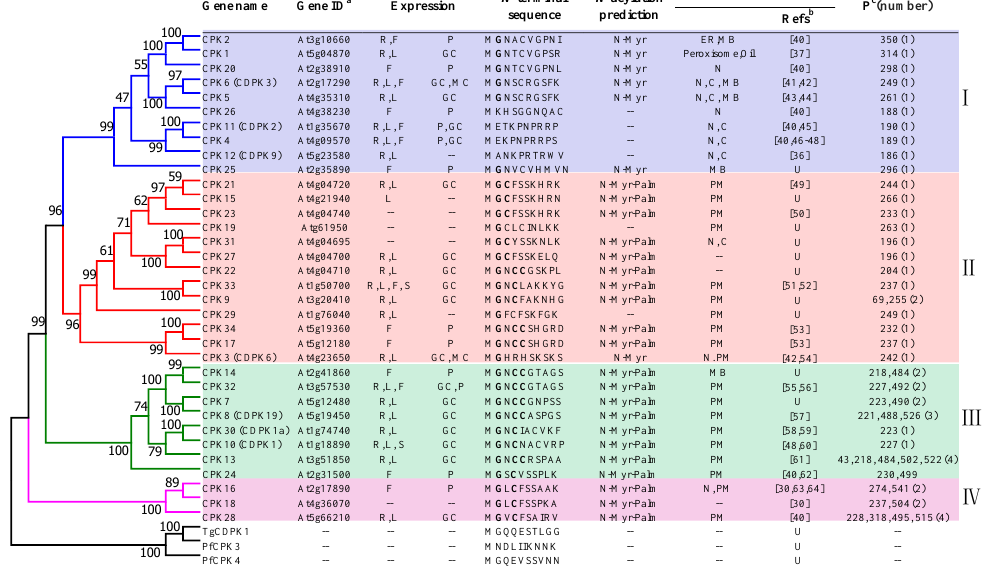
(Figure 2) [34]. The inhibitory-junction domain encompasses a pseudosubstrate auto-inhibitor (20~30 amino acids) and a junction region at its C -terminus, while the CaM-LD domain contains four EF- hands (designated as EF1-EF4) which form the N - and C -terminal EF-hand pair ( N -EF/ C -EF lobe)